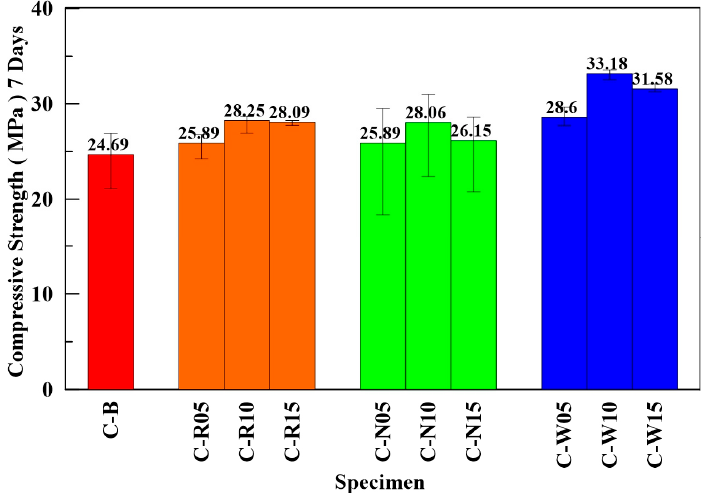
Figure 10. Average compressive strength of ECFRC and benchmark specimens.